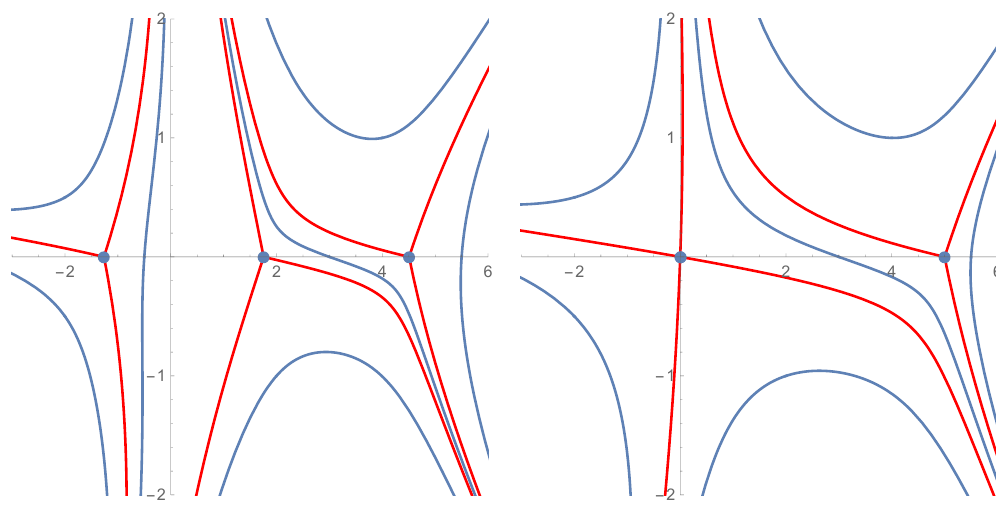
Figure 6 . WKB diagram for the differential equation (B.49). Generic flow lines and WKB lines are colored blue and red respectively.On the left, E > 0 and there are three simple zeros. On the right, E = 0 and there are one simple zero and one second order